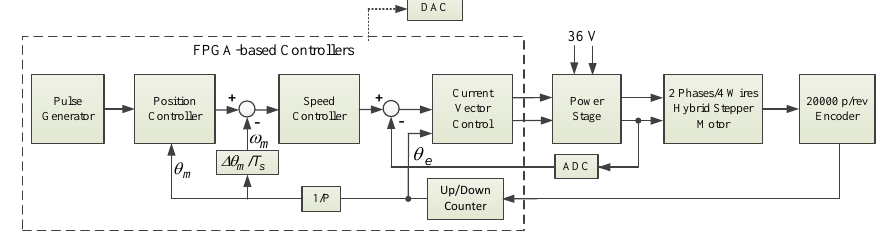
Figure 2. The block diagram of the stepper motor drive system. DAC — digital to analog converter; ADC — analog to digital converter.